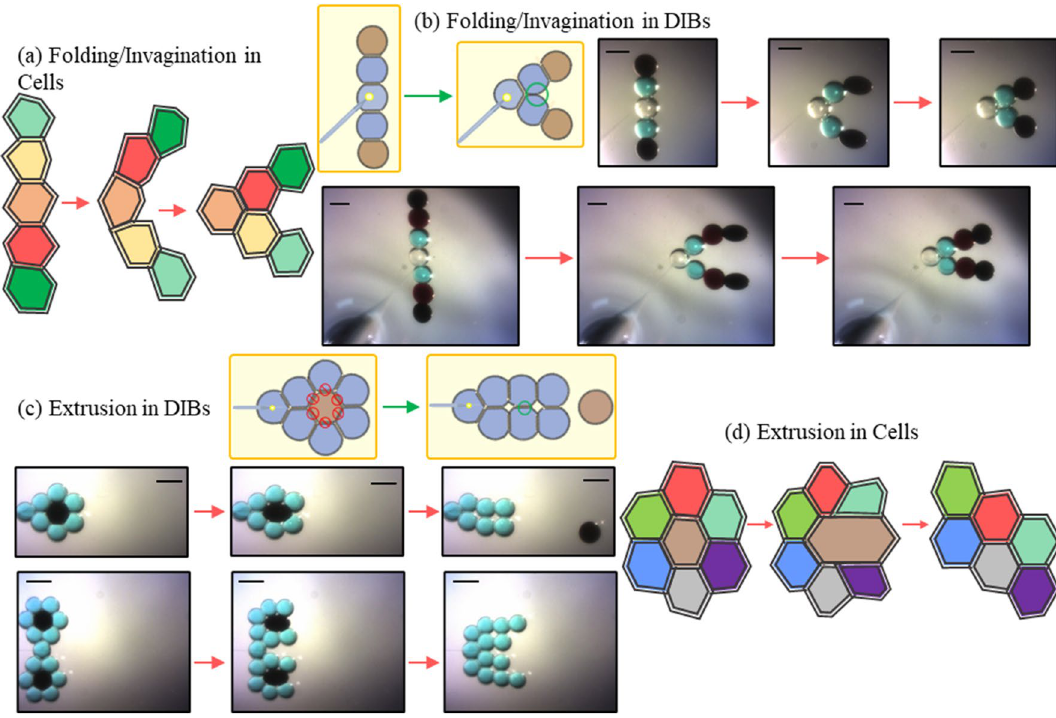
Figure 5. Summary of additional reproduced reconfiguration mechanisms in DIBs. The folding/invagination ( a ) action uses ferrofluid droplets ( b ) to pinch droplets together about a hydrogel anchor. A first case uses two EMG 507 droplets while a second case shows a folding mechanism enabled by using two types of ferrofluids with different concentrations of magnetic particles. The extrusion mechanism ( c ) extracts the ferrofluid droplet from the center of a hexagonal packed structure to form new interfaces. This has been accomplished in ( d ) where a single a double extraction is performed as shown by the experimental images’ series (using EMG 507). DIB structures were formed with aqueous droplets (blue and white colors), EMG 507 (black color) and EMG 509 (brown color) droplets. Scale bars represent 600 µm each. Schematic representations were created by the authors using Microsoft